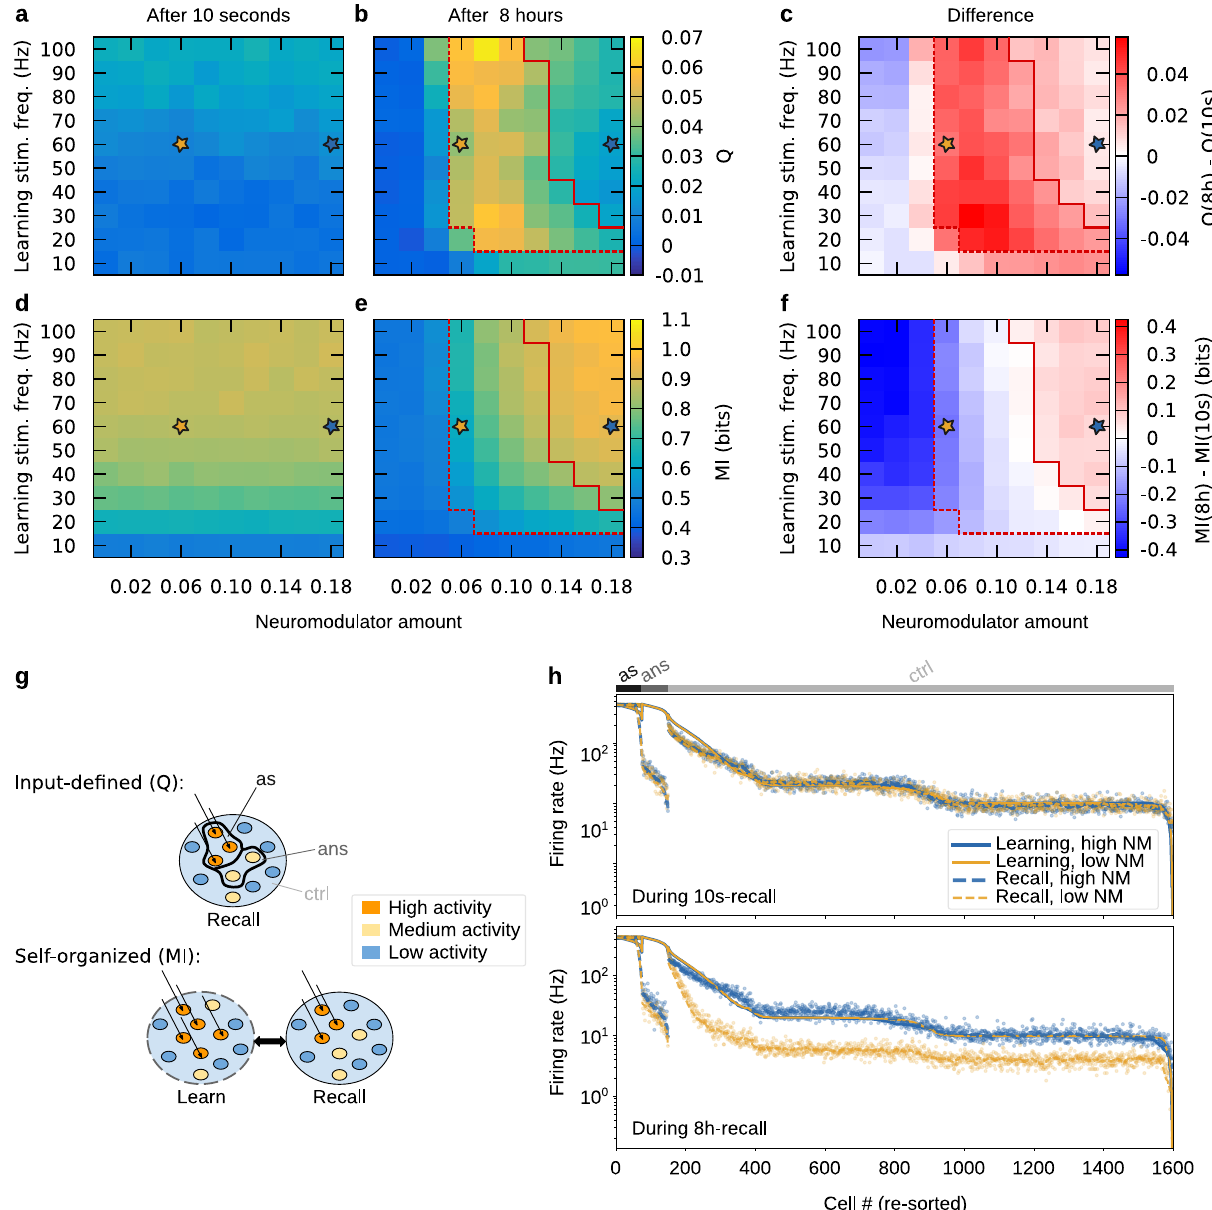
Figure 3. Neuromodulator-dependent consolidation has differential effects on completion of input-defined and self-organized patterns. The performance on completion of an input-defined pattern ( a ) 10 s, and ( b ) 8 h after learning, as measured by the coefficient Q , demonstrates the impact ( c ) of neuromodulator-dependent STC. Analogously, panels ( d – f ) show the performance on completion of a self-organized pattern, measured by mutual information MI . Dashed and solid red lines demarcate where the late-phase weight of core-internal and outgoing synapses reached 150% potentiation, respectively (cf. Fig. 2e, f). ( g ) Depicts the definitions of the two performance measures— Q depends on the activities during recall in the subpopulations “as”, “ans”, and “ctrl”, which are defined by the inputs for learning and recall, while the mutual information MI depends on the relationship between the activities during learning and during recall. Colors represent neuronal firing rates. ( h ) Shows the firing rates of the excitatory neurons grouped by subpopulation. Each subpopulation has been sorted according to their firing rate during learning. Data in ( a – f ) were averaged over 50 solid red lines emphasize that these findings are correlated with the outgrowth shown in Fig. 2e, f. The difference in the two measures at the level of firing rates becomes evident from Fig. 3h, which shows that after consolida- tion, a high neuromodulator amount gives rise to much more activity in the control population, whose neurons are recruited into the self-organized pattern. Note that in the next subsection, we will examine how these rich dynamics can serve to store temporal structures.